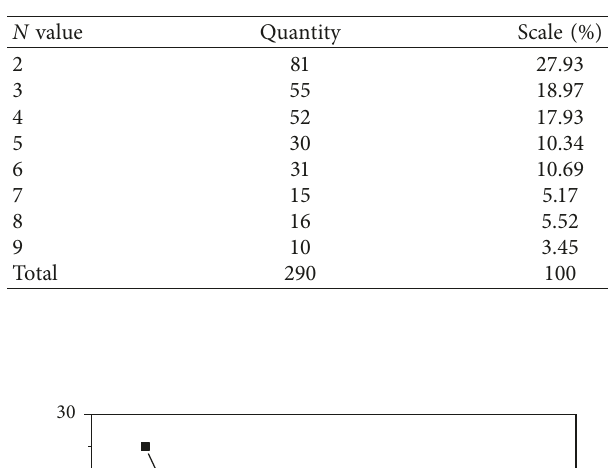
Table 3: Candidate lexical chunks automatically extracted